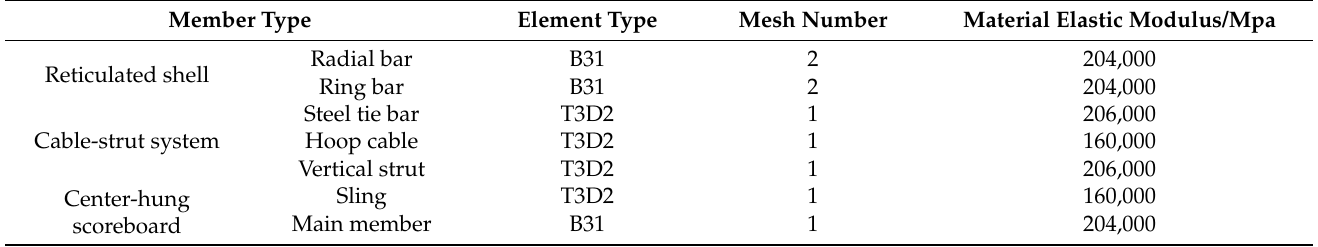
Figure 11. Numerical model: ( a ) Without center-hung scoreboard; ( b ) With center-hung scoreboard. Table 5. Parameters of numerical model